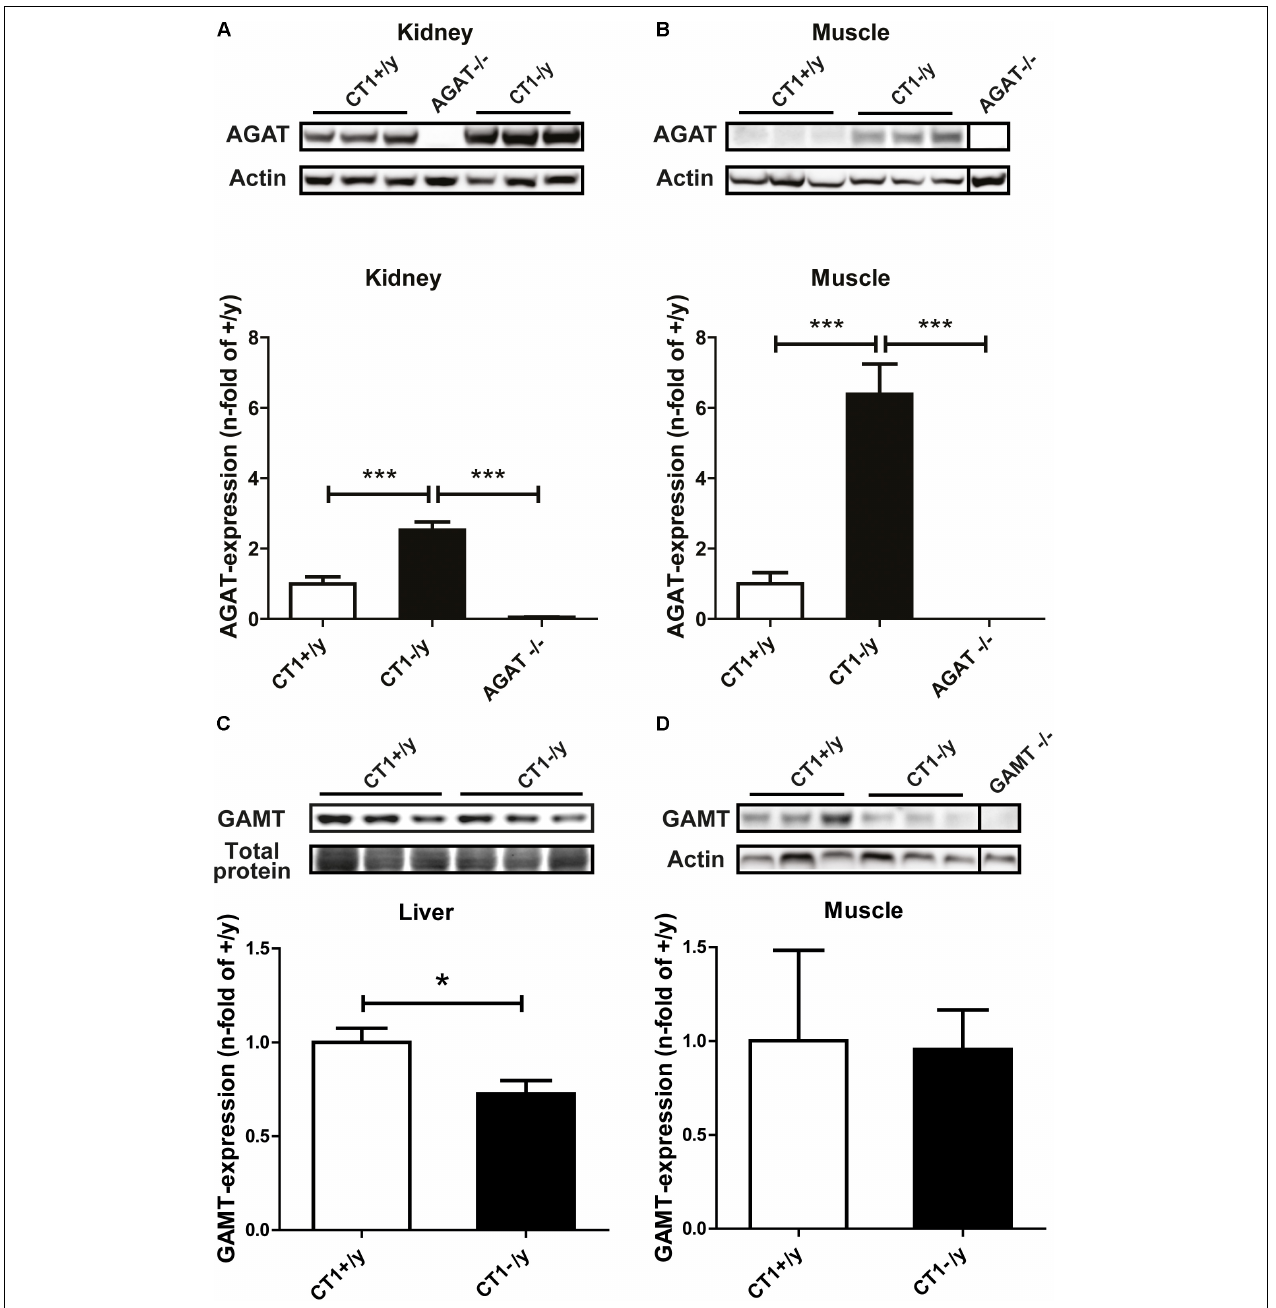
FIGURE 2 | L -Arginine:glycine amidinotransferase and GAMT expression. Relative quantification of AGAT protein levels in kidney (A) and muscle (B) of CT1 − / y mice ( n = 5–6). Relative quantification of GAMT protein levels in liver (C) and muscle (D) of CT1 − / y mice ( n = 6). Tissue samples of AGAT − / − and GAMT − / − mice to verify antibody specificity ( ∗ P < 0.05; ∗∗∗ P <